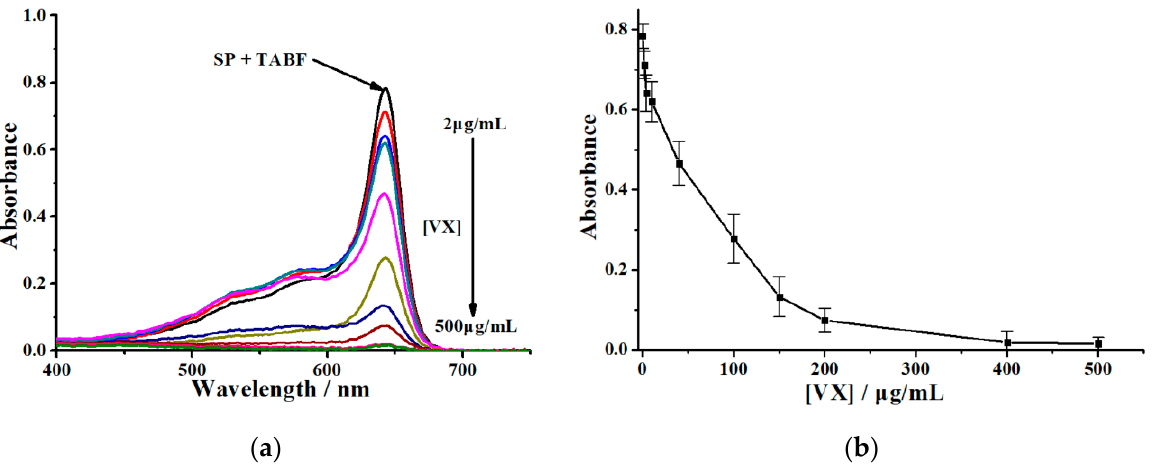
Figure 2. ( a ) UV − Vis spectra changes in colorimetric solution with increasing VX concentration; ( b ) curve of absorbance with VX concentration at 644 nm.